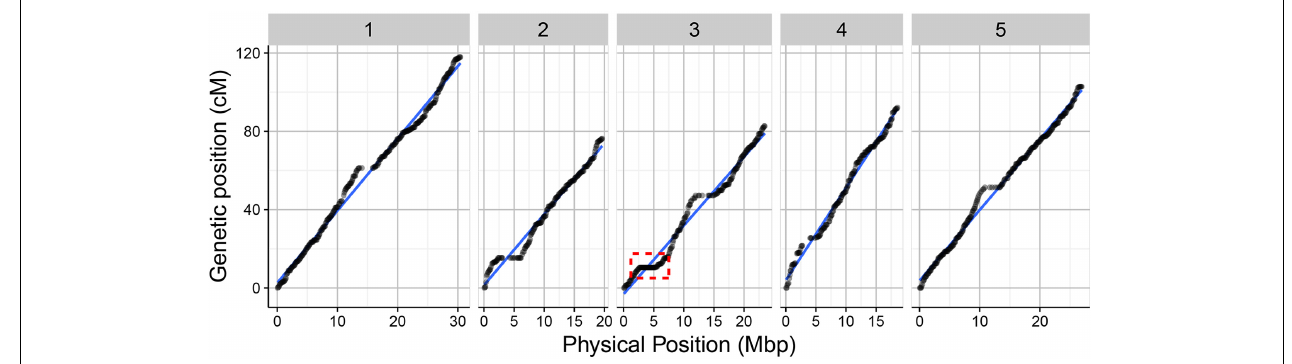
FIGURE 5 | Relation between the genetic length in centimorgans (cM) and the physical length in Mbp for the 1059 markers along the five chromosome using 160 RILs of the Bay-0 × Sha RIL population. The red dotted frame indicates the region on the upper arm of chromosome 3 without recombination events.